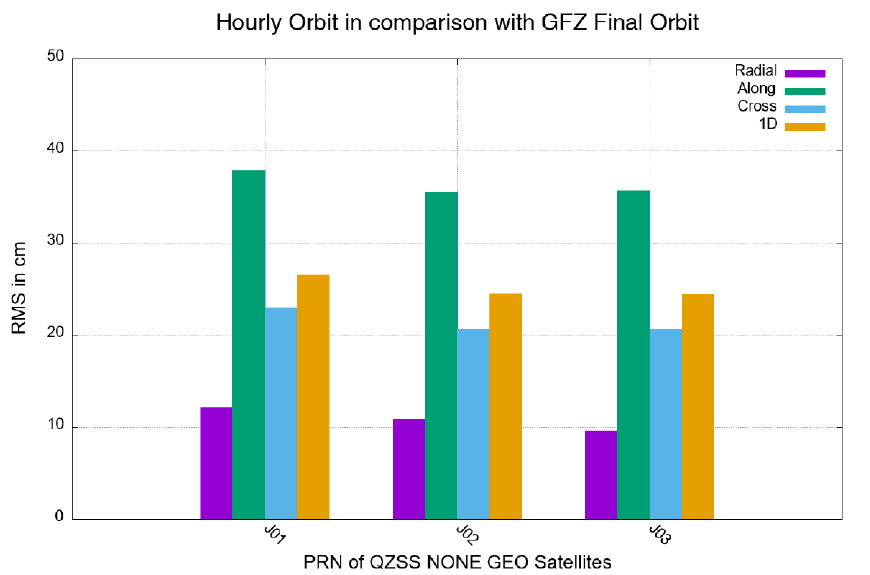
Figure 7. Mean RMS in the RAC components and 1-D of Galileo satellites in comparison with GFZ final orbit.